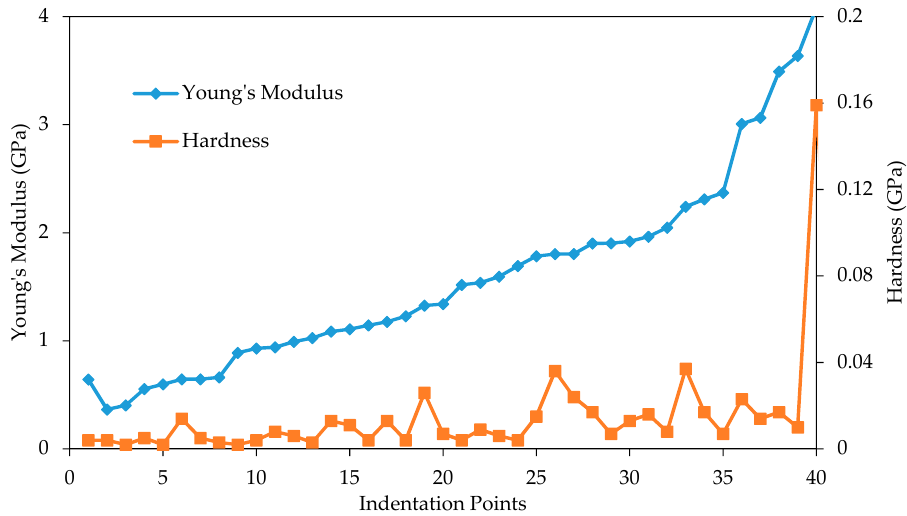
Figure 12. Young’s modulus and hardness in mastic phase of sample without hydrated lime.